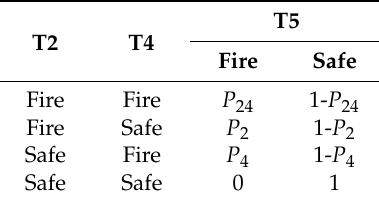
Figure 8. Application of Bayesian network (BN) to modelling fire domino effect in the terminal. ( a ) The domino effect starts from T1. ( b ) The domino effect starts from T1 and T5.